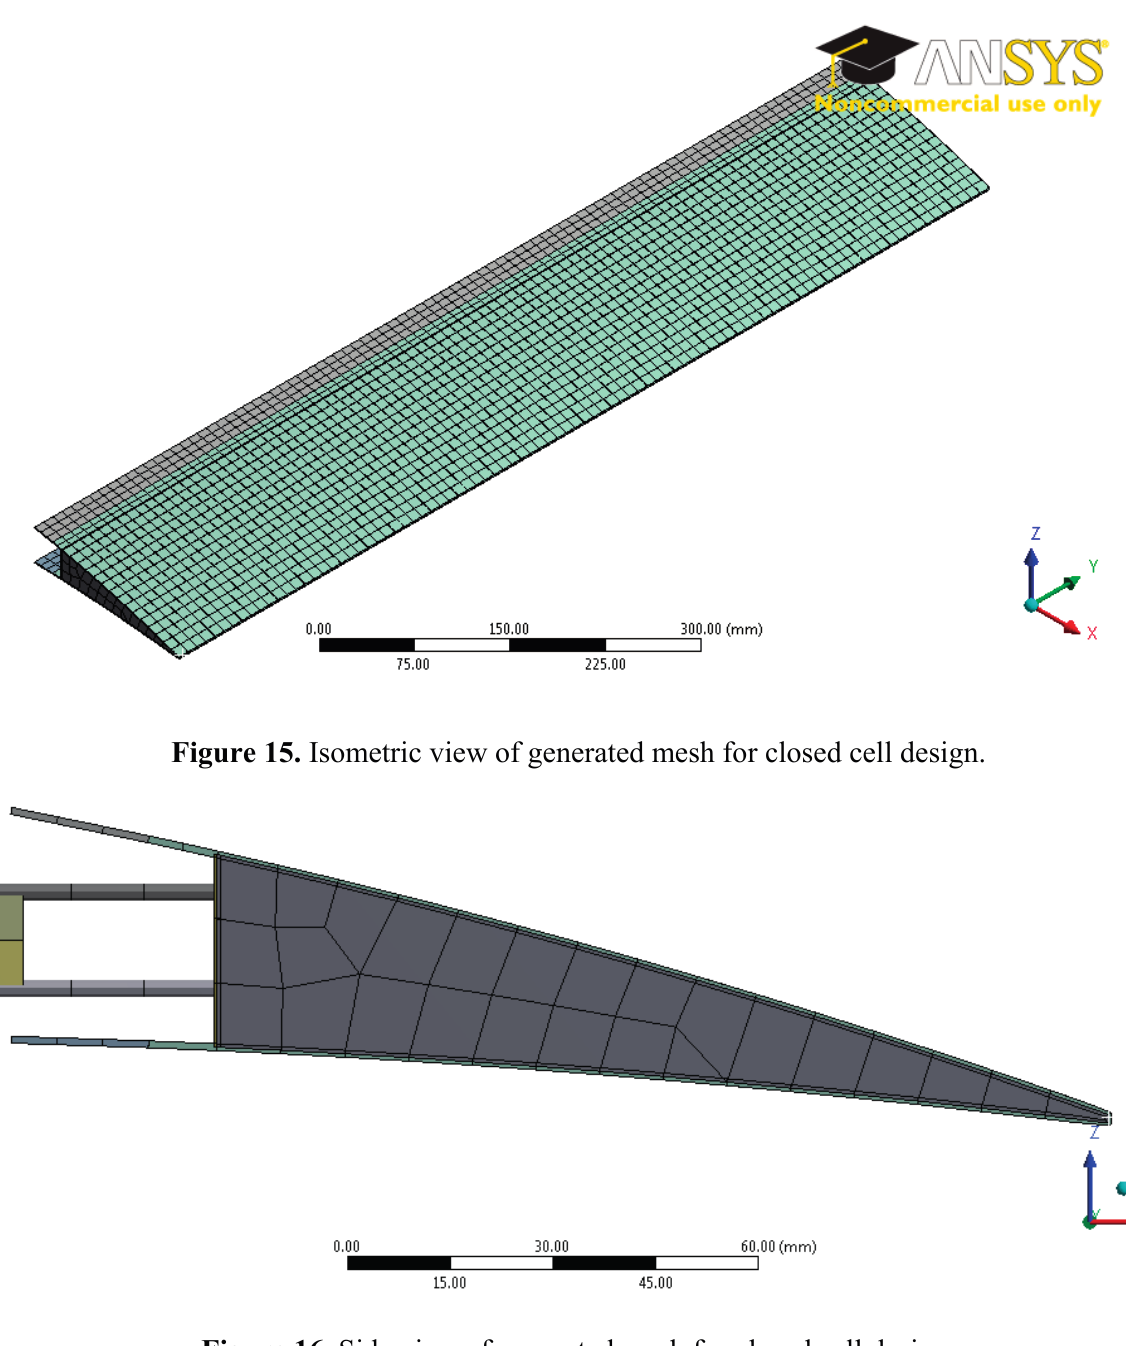
Figure 16. Side view of generated mesh for closed cell